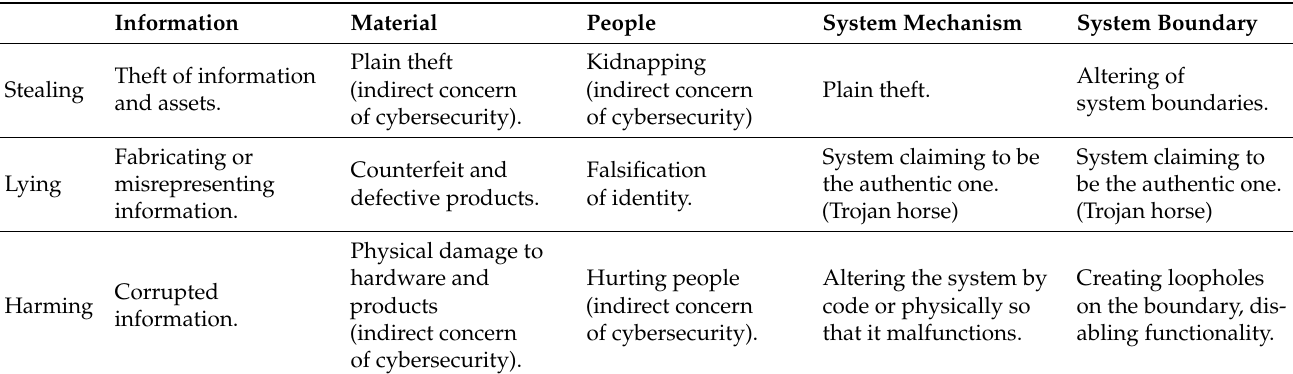
Table 5. Forms of wrongs that can occur to elements